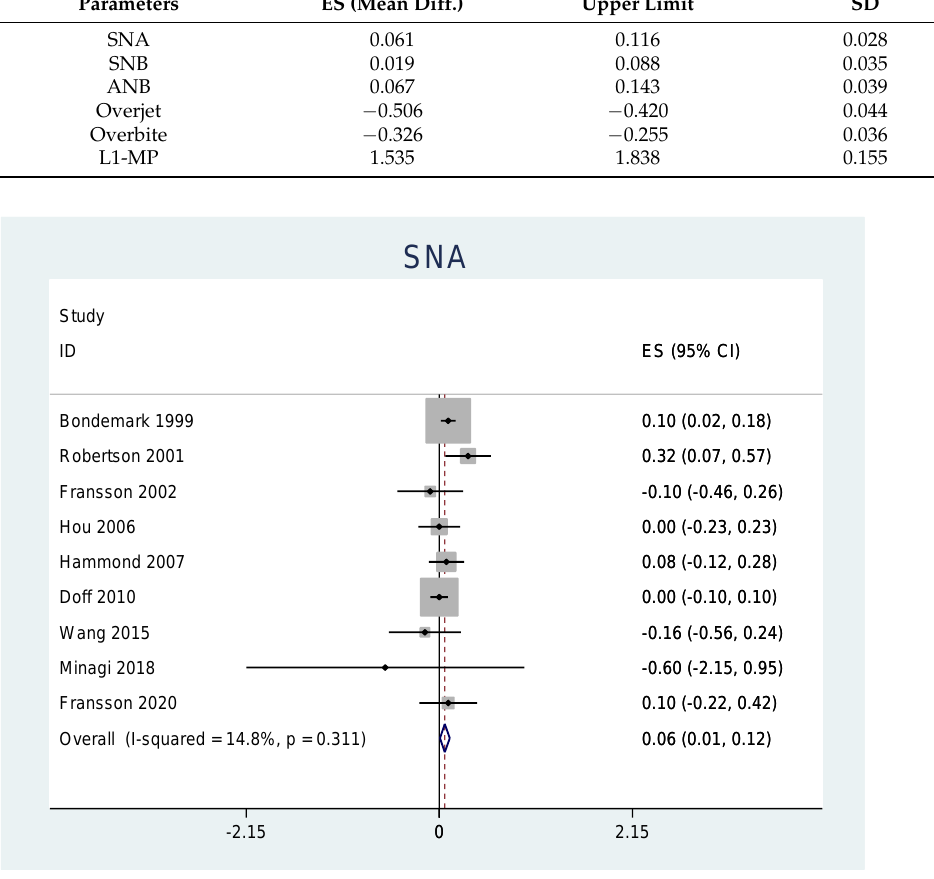
Figure 2. Forest plot of the results of SNA changes using the random-effects model.